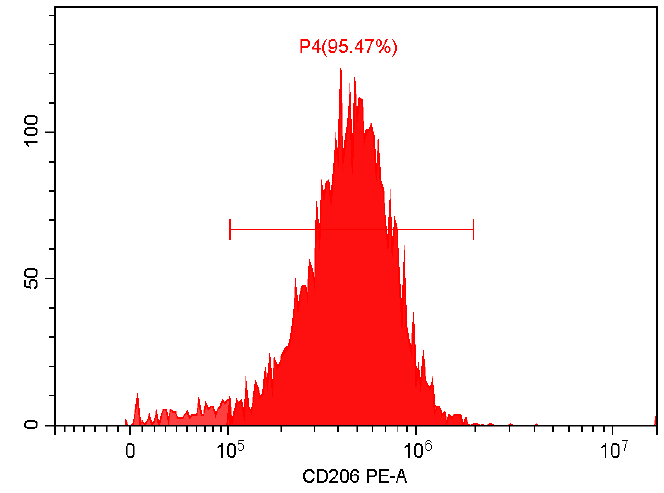
Figure A1. 1 H NMR spectrum of M2pep ( A ) and DOTA-M2pep ( B ) in DMSO. Δ = 6.5~8.5 ppm (M2pep).